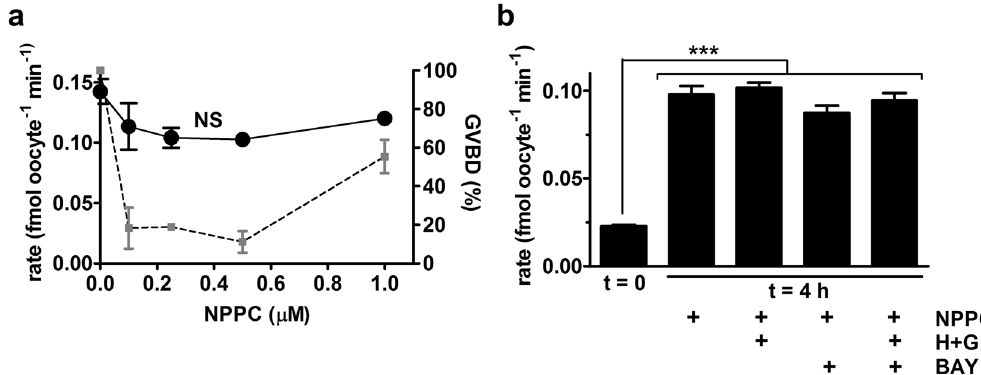
Figure 2. Effect of NPPC on GLYT1 activation. ( a ) GLYT1 activity (black circles) was measured as the rate of transport of [ 3 H]-glycine by oocytes isolated from COCs that had been cultured for 4 h as a function of NPPC concentration (0–1 µ M) during culture. Increasing NPPC concentration had no significant effect on GLYT1 activity (NS, by ANOVA, P = 0.16). The extent of GVBD in the oocytes used for GLYT1 activity measurements here was previously reported 21 , and are replotted here (gray squares) for reference. Each point represents the mean ± s.e.m. of 3 or 4 independent repeats. ( b ) Various inhibitors were tested for an effect on the development of GLYT1 activity in oocytes within COCs cultured for 4 h in the presence of NPPC (100 nM) and E 2 (100 nM). As shown in (A), culture with NPPC alone had no significant effect, nor did culture with NPPC and either hypoxanthine (4 mM) and guanosine (50 µ M) together (H + G), the PDE9 inhibitor BAY 73-6691(BAY), or all three together. Data were analysed by ANOVA with Tukey test (overall effect: P < 0.0001; between